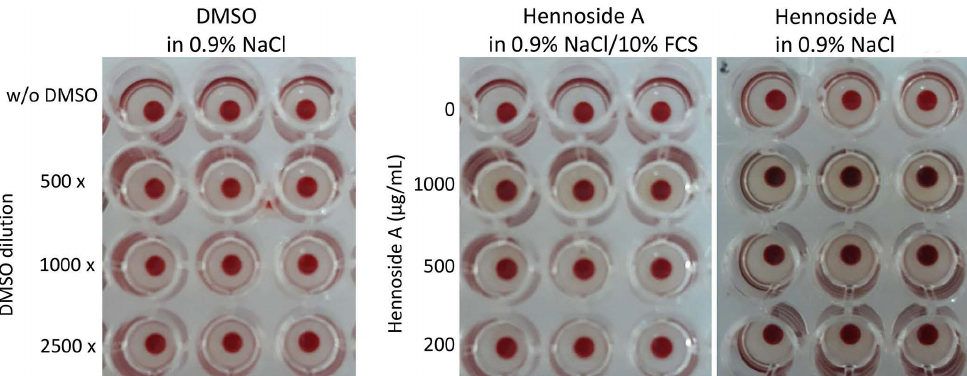
Figure 4. Hennoside-induced changes in color of erythrocytes. The image depicts the remaining non-lysed/intact erythrocytes after 90 min incubation, at 37 ◦ C with hennosides diluted in 0.9% NaCl or 0.9% NaCl containing 10% FCS. DMSO diluted in 0.9% is used as a control. The results show non-hemolytic effect of